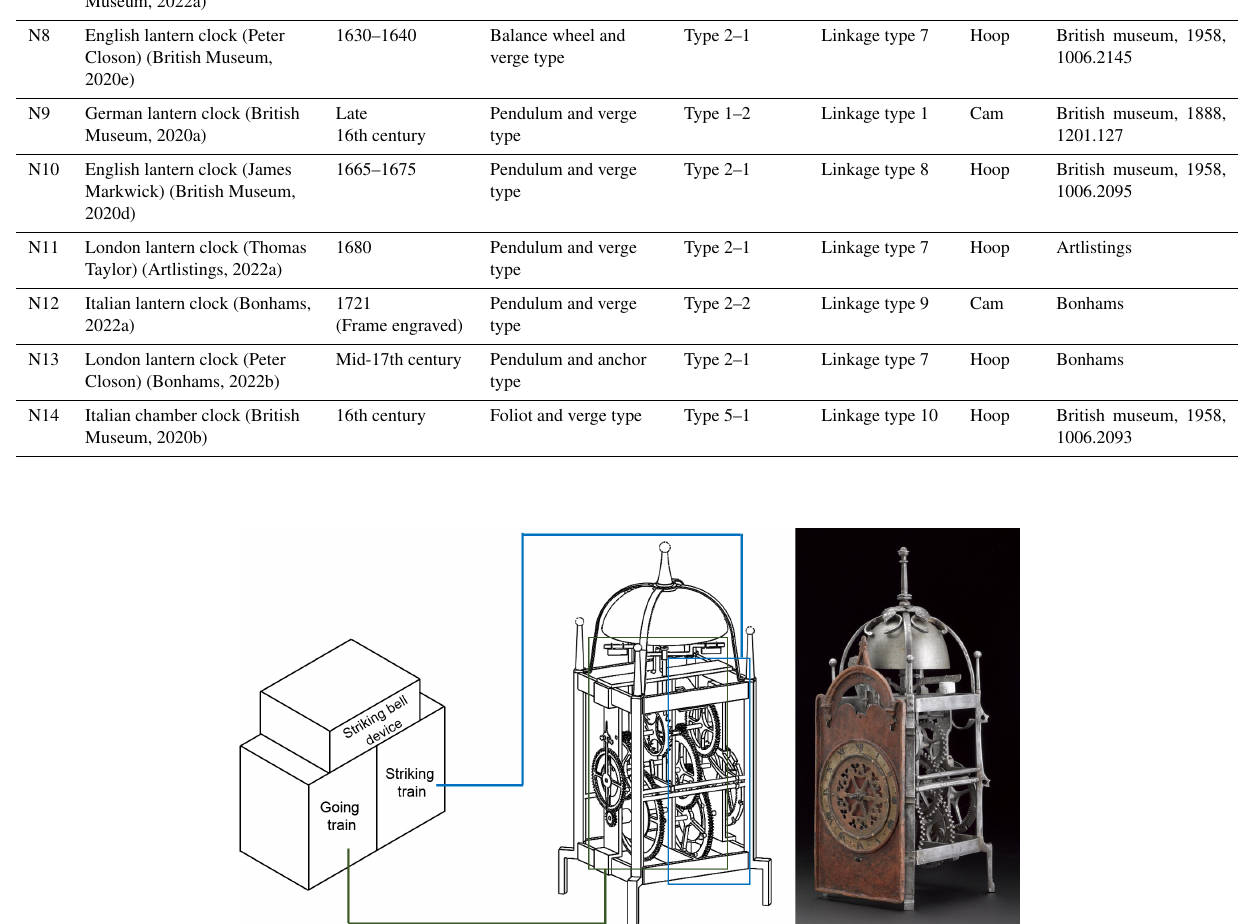
Figure 2. N2 – Liechti iron chamber clock (Science Museum,